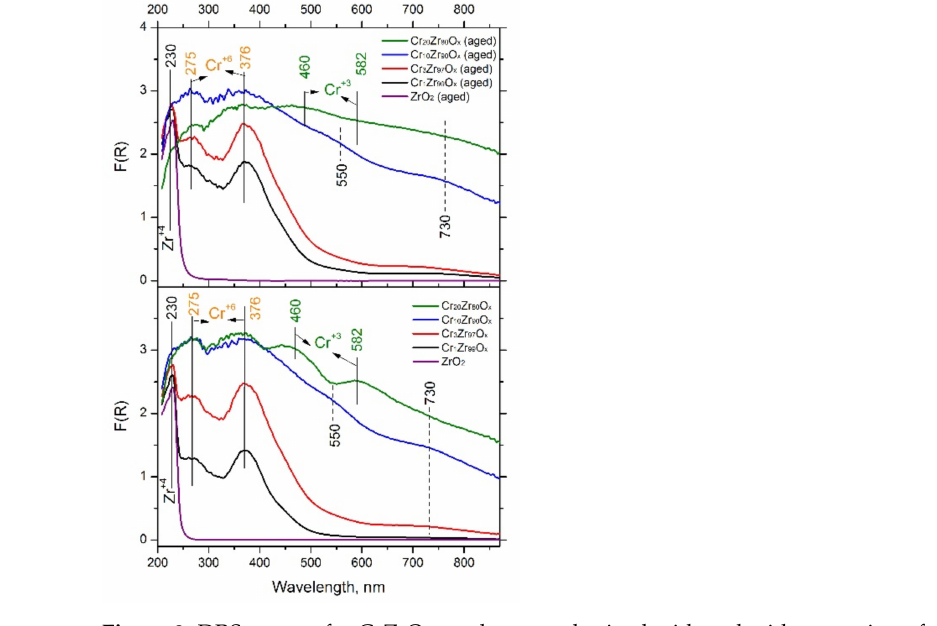
Figure 3. DRS spectra for CrZrO x catalysts synthesized with and without ageing of